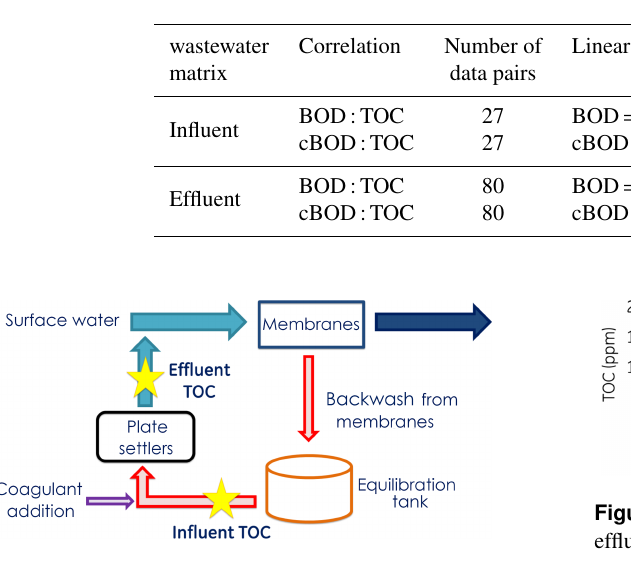
Figure 2. Schematic flow diagram of Twin Oaks Water Treatment Plant’s implementation of TOC Analyzer.